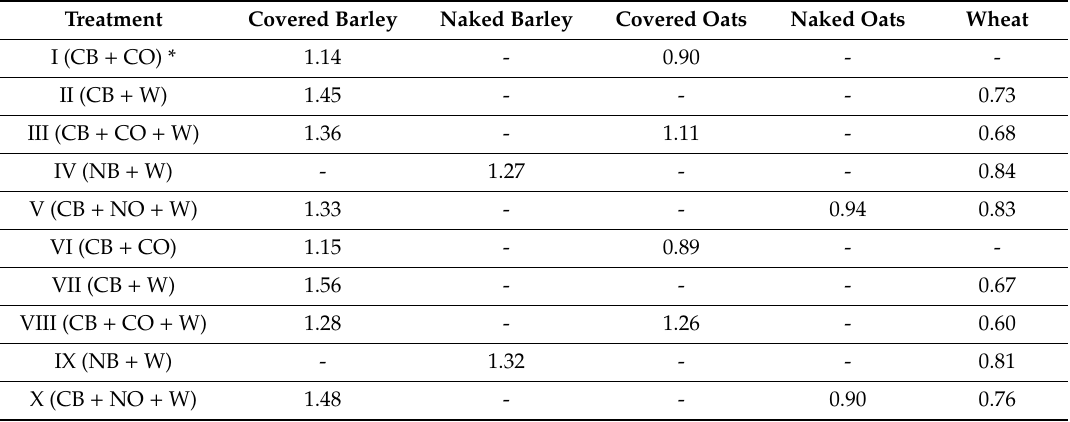
Table 10. Yield suppression ratio of the mixture components on the soil of Albic Luvisols.